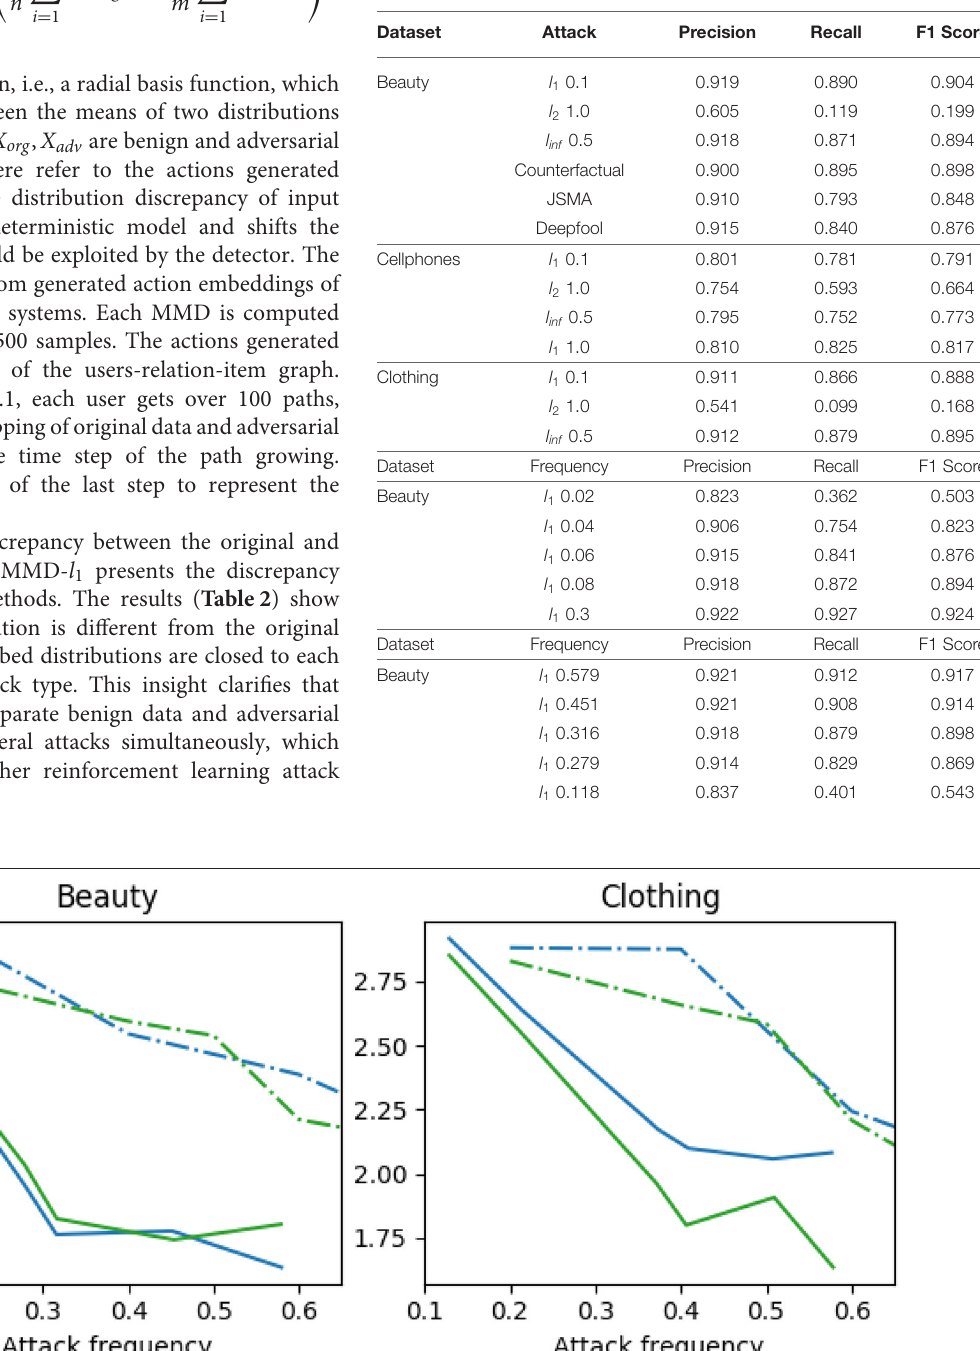
TABLE 3 | Detection result and factor analysis.